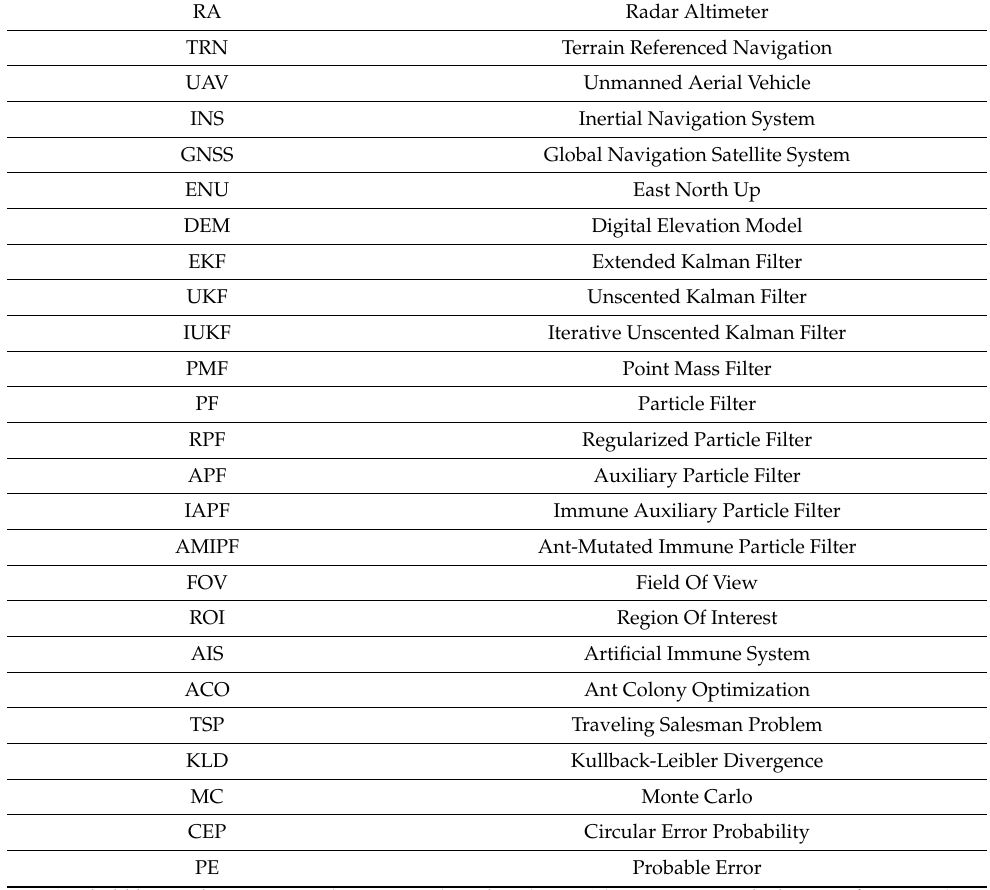
Table 1. List of